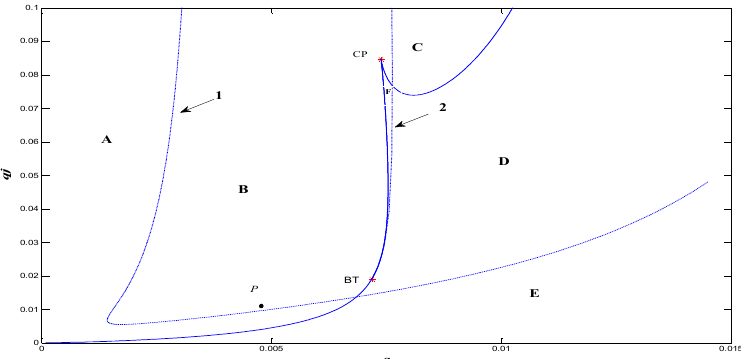
Figure 6. Two-parameter bifurcation diagram of the Oxo reaction model. BT stands for a Bogdanov–Taken point, and CP stands for a cusp point. Any points in section A generate a unique stable point thatcoverts to the low conversion region; points in section E generate three equilibriums, the high and low conversion ones are stable while the middle one is a saddle; points in section B generate one stable limit cycle; points in section C generate a unique stable point thatcoverts to the low conversion region; points in section D generate three equilibriums, the high conversion region is a stable limit cycle, then a saddle, and a stable point at the low conversion region; points in section F generate a saddle that is incorporated by a limit cycle.